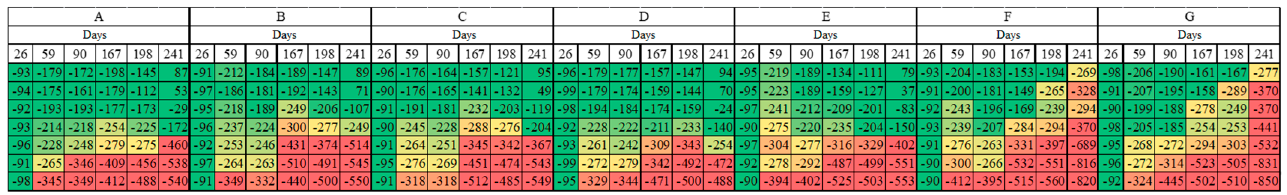
Figure 9. Corrosion Potential of bars in mV vs. Cu/CuSO4—circular pier.